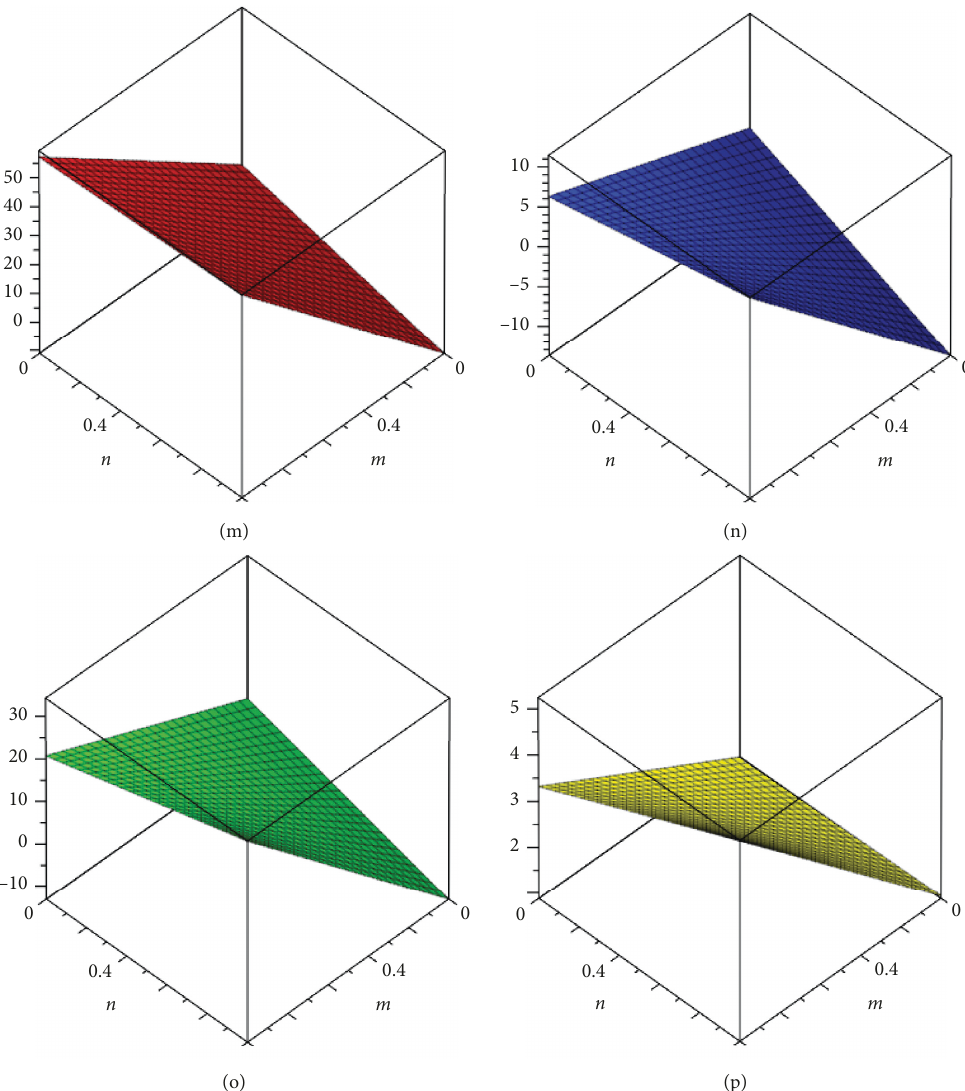
Figure 5: (a) VAR ( m − BiI (g) IRA ( m − BiI (n) IRLA ( m − BiI